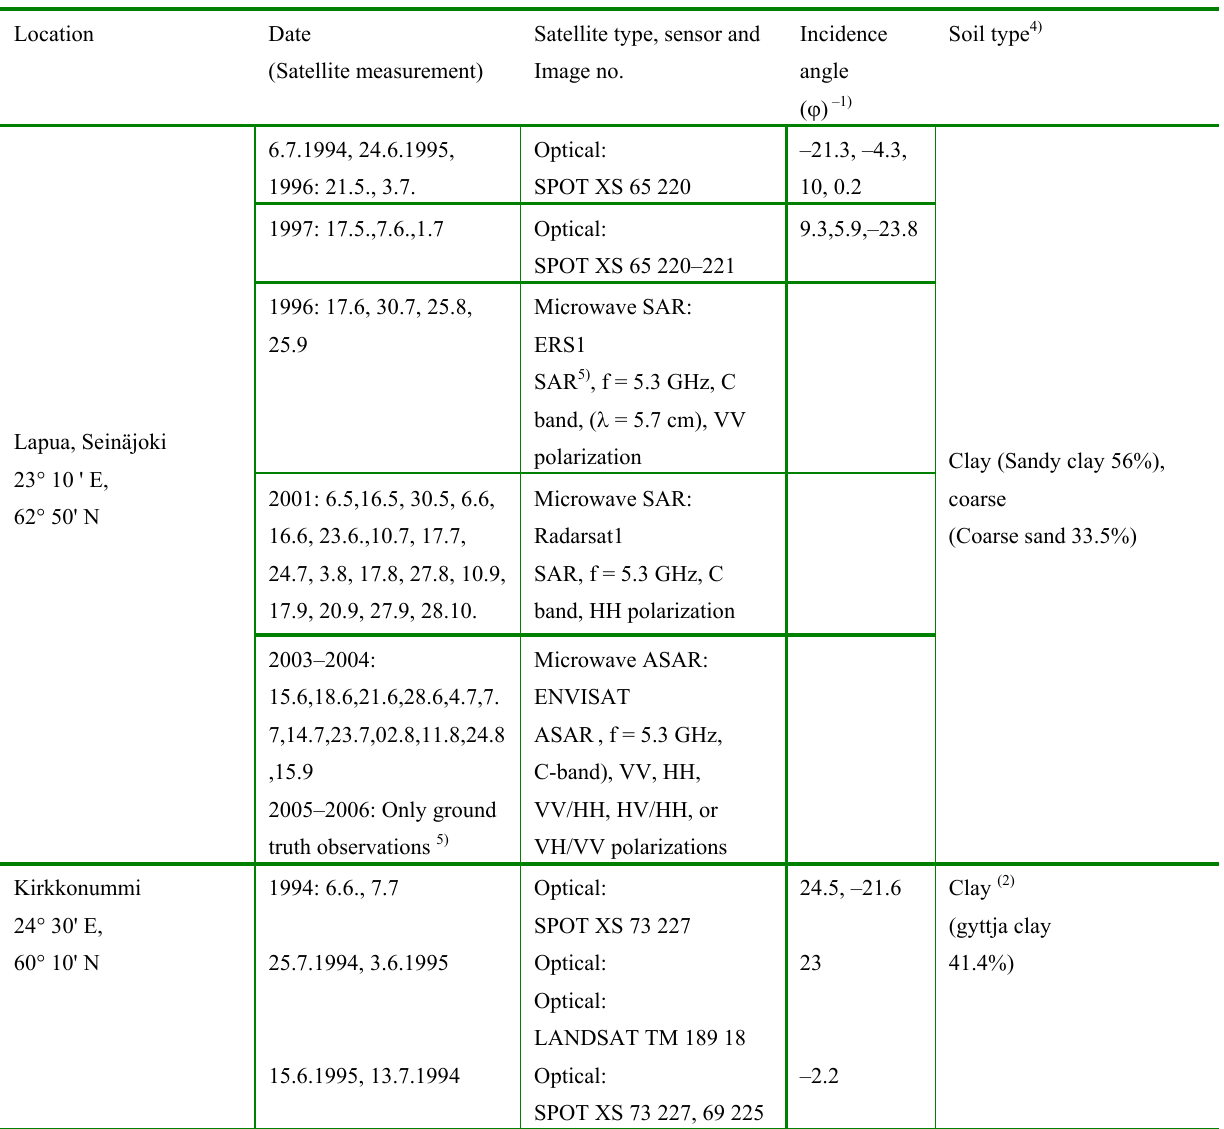
Table 9. Satellite measurements in Finnish experimental locations